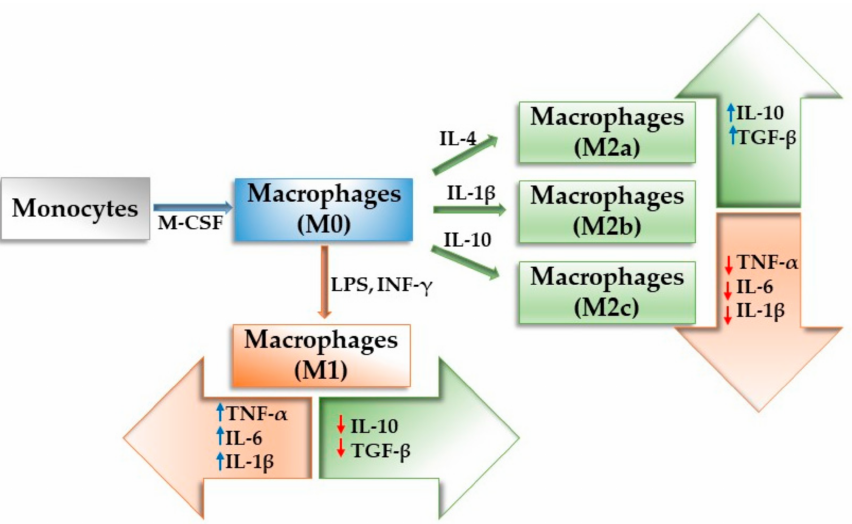
Figure 4. Polarization of macrophages and the released cytokines. ↑ indicates upregulated production; ↓ indicates downregulated production; IL—interleukin; TGF- β —transforming growth factor β ; TNF- α —tumor necrosis factor α ; INF- γ —interferon γ ;